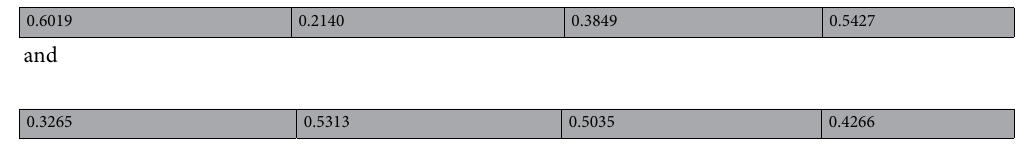
Step-3 Determine the distance between the positive and negative ideal solutions.